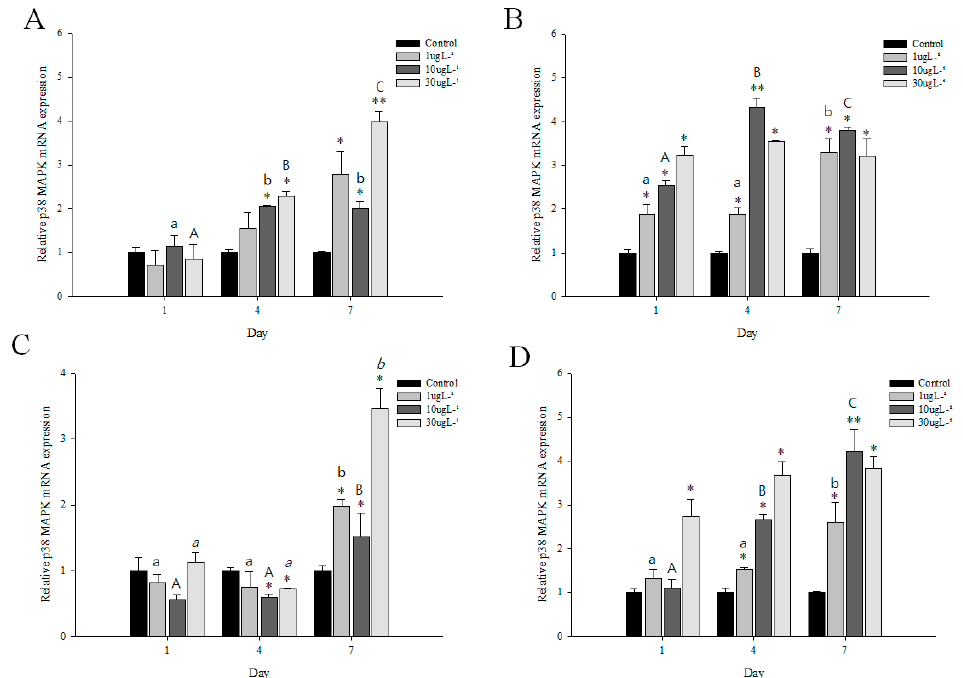
Figure 5. Relative expression of p38 MAPK mRNA in M . japonicus gills ( A , C ) and hepatopancreas ( B , D ) exposed to 1, 10, and 30 µ g L − 1 DEHP ( A , B ) and BPA ( C , D ) at days 1, 4, and 7. The values were normalized against GAPDH. Values of each bar represent the mean ± SD. A statistically significant di ff erence is presented by an asterisk at * p < 0.05 and ** p < 0.01 compare with the control (relative control value of p38 MAPK =